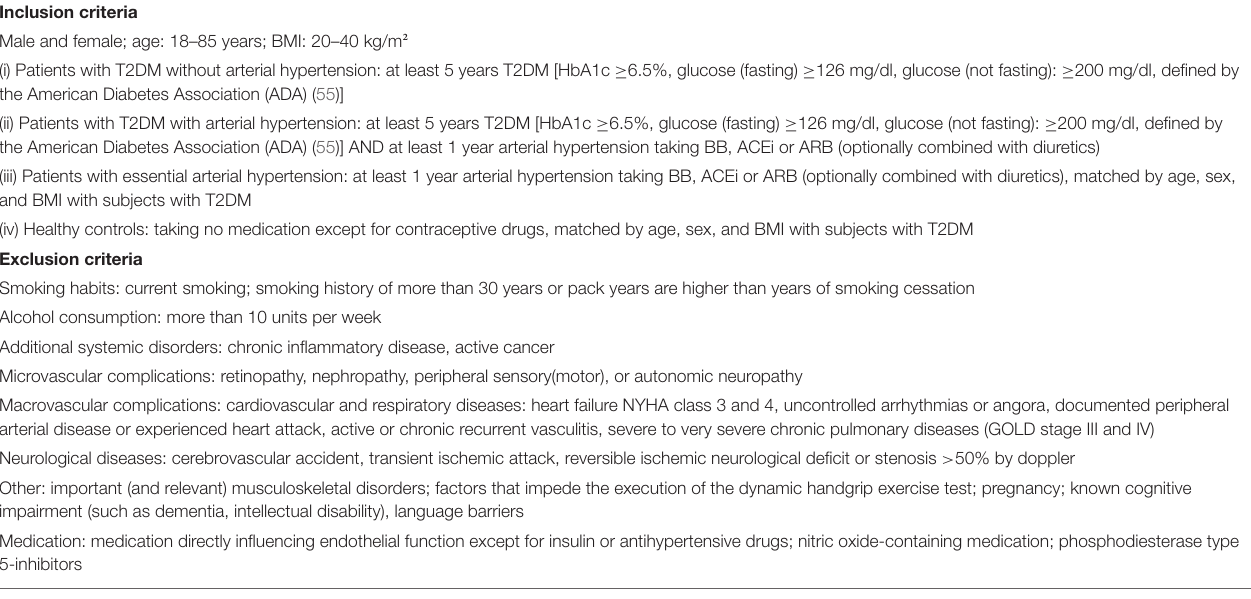
TABLE 2 | In- and exclusion criteria for participants in this study. Inclusion